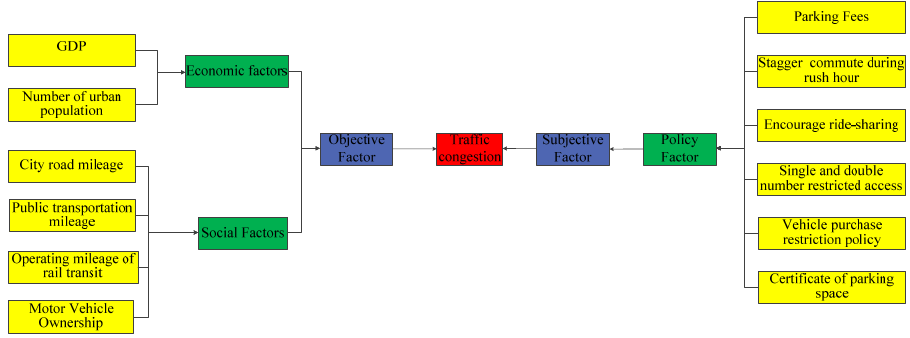
Figure 4. Traffic Congestion Influencing Factor System.